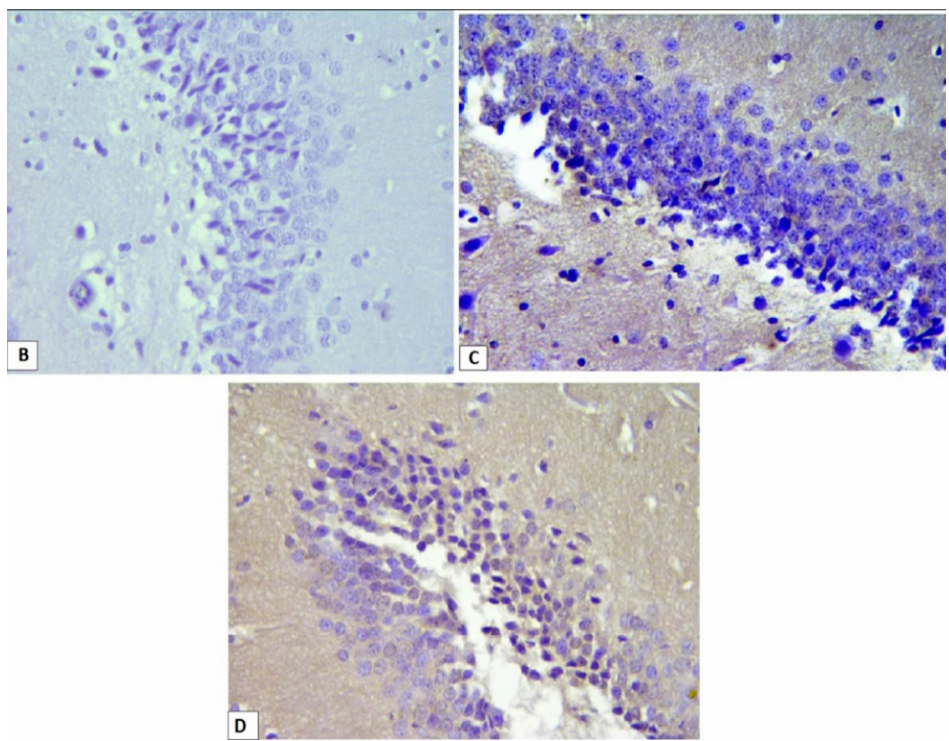
Figure 4. Mean area of interest of Hsp70 positivity in the CA3 region of hippocampus from different groups ( A ). The HSP70 protein expression mean area of interest was compared between the three groups (PTZ + Sal, Sal + Sal and PTZ + L -Car using one-way ANOVA. F(2,15)=20.53, p < 0.0001. Tukey multiple comparisons test was done between the groups. There was a significant difference between PTZ + Sal vs. PTZ + L -Car (*) mean difference = − 43.67. 95% CI of difference = − 67.47 to − 19.86, p = 0.0007) and also between Sal + Sal vs. PTZ + L -Car (*) mean difference = − 55.83. 95% CI of difference = − 79.64 to − 32.03, p < 0.0001. Section of brain in the CA3 region of hippocampus showing negative expression for Hsp70 in the Sal group ( B , 200×), moderate cytoplasmic expression in the Sal + PTZ group ( C , 200×) and high cytoplasmic brown staining for Hsp70 in the L -Car + PTZ group ( D , 200×).